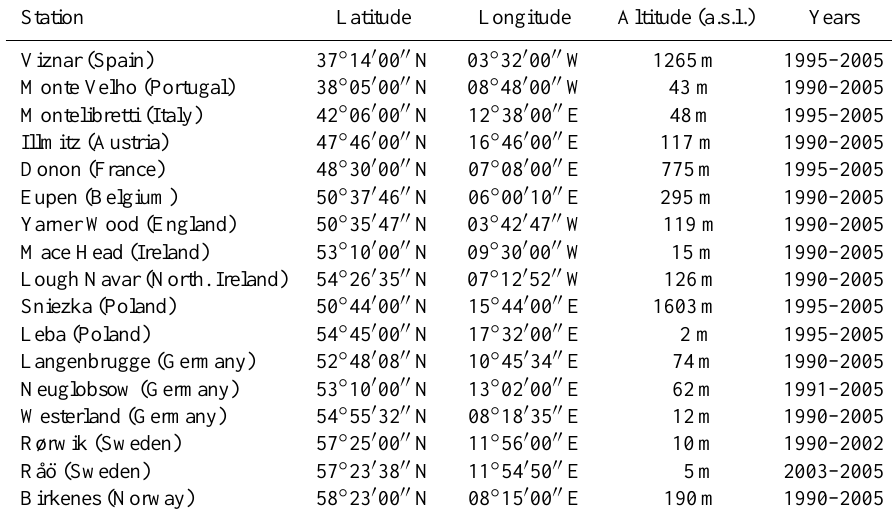
Table 1. Ground stations with geographical coordinates and years used in the